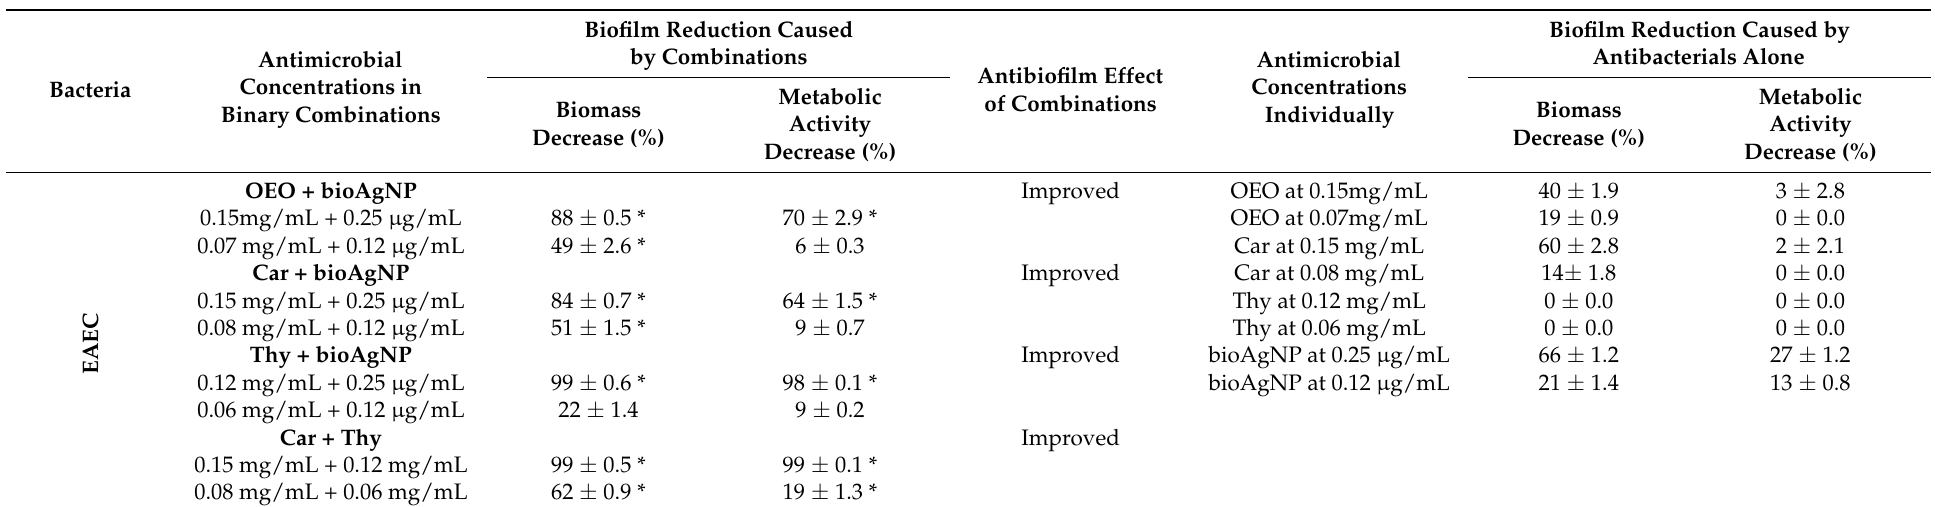
Table 3. Antibiofilm effect, shown in terms of biomass and metabolic activity reduction, of oregano derivatives combined with biological silver nanoparticles (bioAgNP) compared to both antimicrobials individually against enteroaggregative Escherichia coli (EAEC 042) biofilms growth in microtiter plates, which were evaluated at an early stage of biofilm